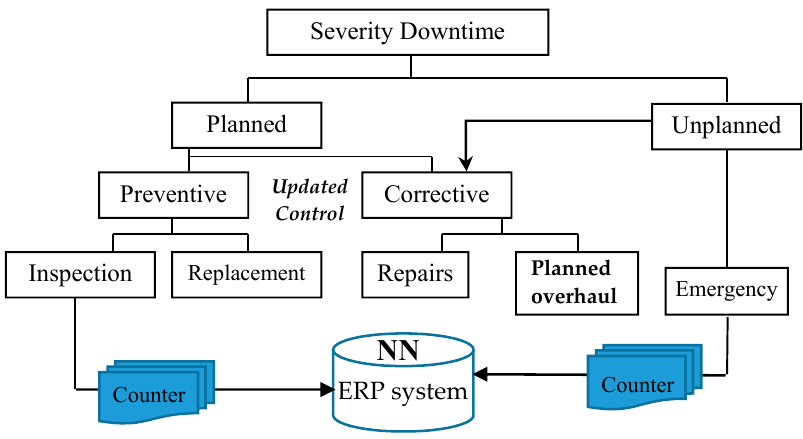
Figure 6. The types of maintenance causes.